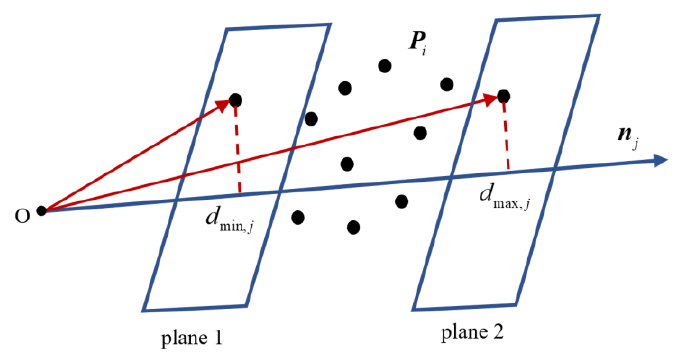
Figure 2. Parallel planes of a k-DOPS bounding box.